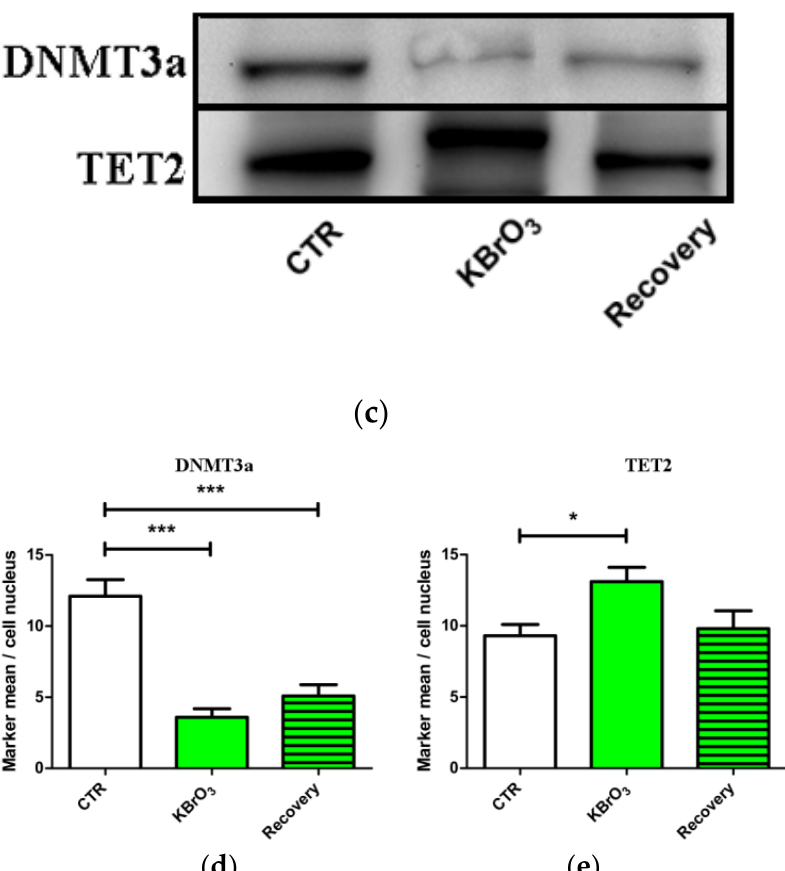
Figure 2. ( a ) DNMT3a labelling (arrowheads). The enzyme localized in the heterochromatic regions and at its surface. Bars: 1 μm (control); 500 nm (KBrO 3 and recovery). ( b ) TET2 labelling (arrowheads). Note the localization at euchromatin-heterochromatin surface. Bars: 500 nm (control and KBrO 3 ); 1 μm (recovery). ( c ) Western blot analysis of potassium bromate-treated cells with antibody targeting DNMT3a and TET2 (see Figure S1). ( d , e ) Histograms representing the abundancy of DNMT3a and TET2 per nucleus. Asterisks identify colloidal gold counting-revealed significant differences. Mean with SEM are reported (*: p Value < 0.05; ***: p Value < 0.001).